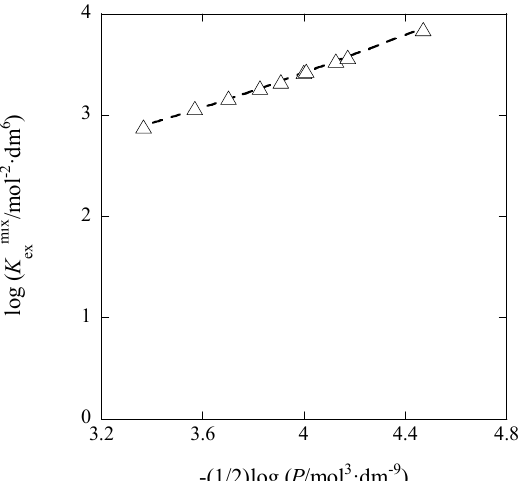
Figure 4. A plot of log K exmix vs. − (1/2)log P for the AgClO 4 extraction with B18C6 (= L) into DCE. The regression line was log K exmix = log(2.5 × 10 2 + (cid:3493)0.057 (cid:2873) /(cid:1842) ) at r = 0.999.